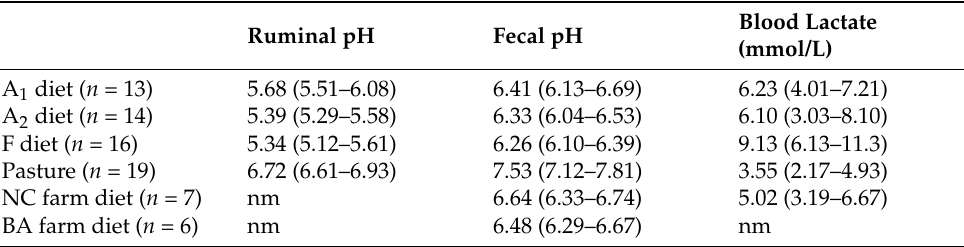
Table 8. Overall averages of ruminal and fecal pH and blood lactate evaluated in cattle raised in the two feedlot systems and those raised in pastures without concentrate intake.